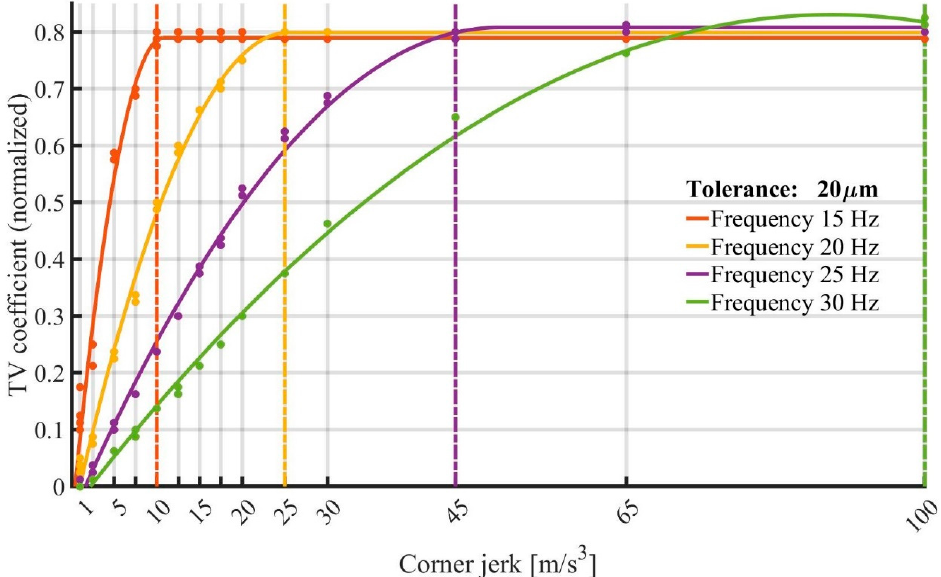
Figure 9. Dependence of the TV parameter on corner jerk values for contour tolerance of 20 μm and tested limit frequencies based on the “Fan” toolpath results. The results for individual frequencies are distinguished by color. The regression curves are displayed as solid lines. The corner jerk threshold values are displayed as vertical dashed lines. The (normalized) test values of TV are displayed as full dots. The results for the limit frequency of 10 Hz require a different modelling approach; see Figure 10.